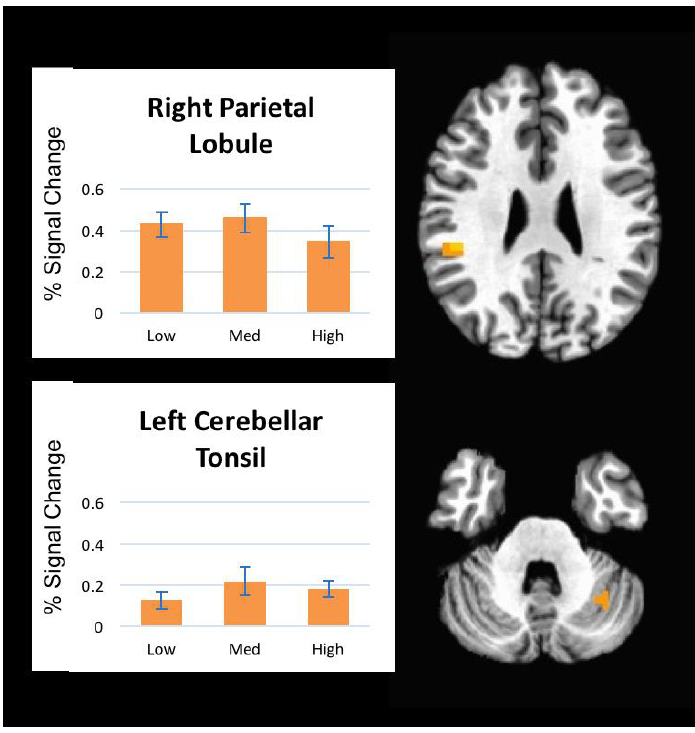
Figure 4. Increased brain activation in response to mechanical pressure when compared to rest. Table 1. Brain activation in response to mechanical pressure on the lumbar spine, FDR p < 0.05.